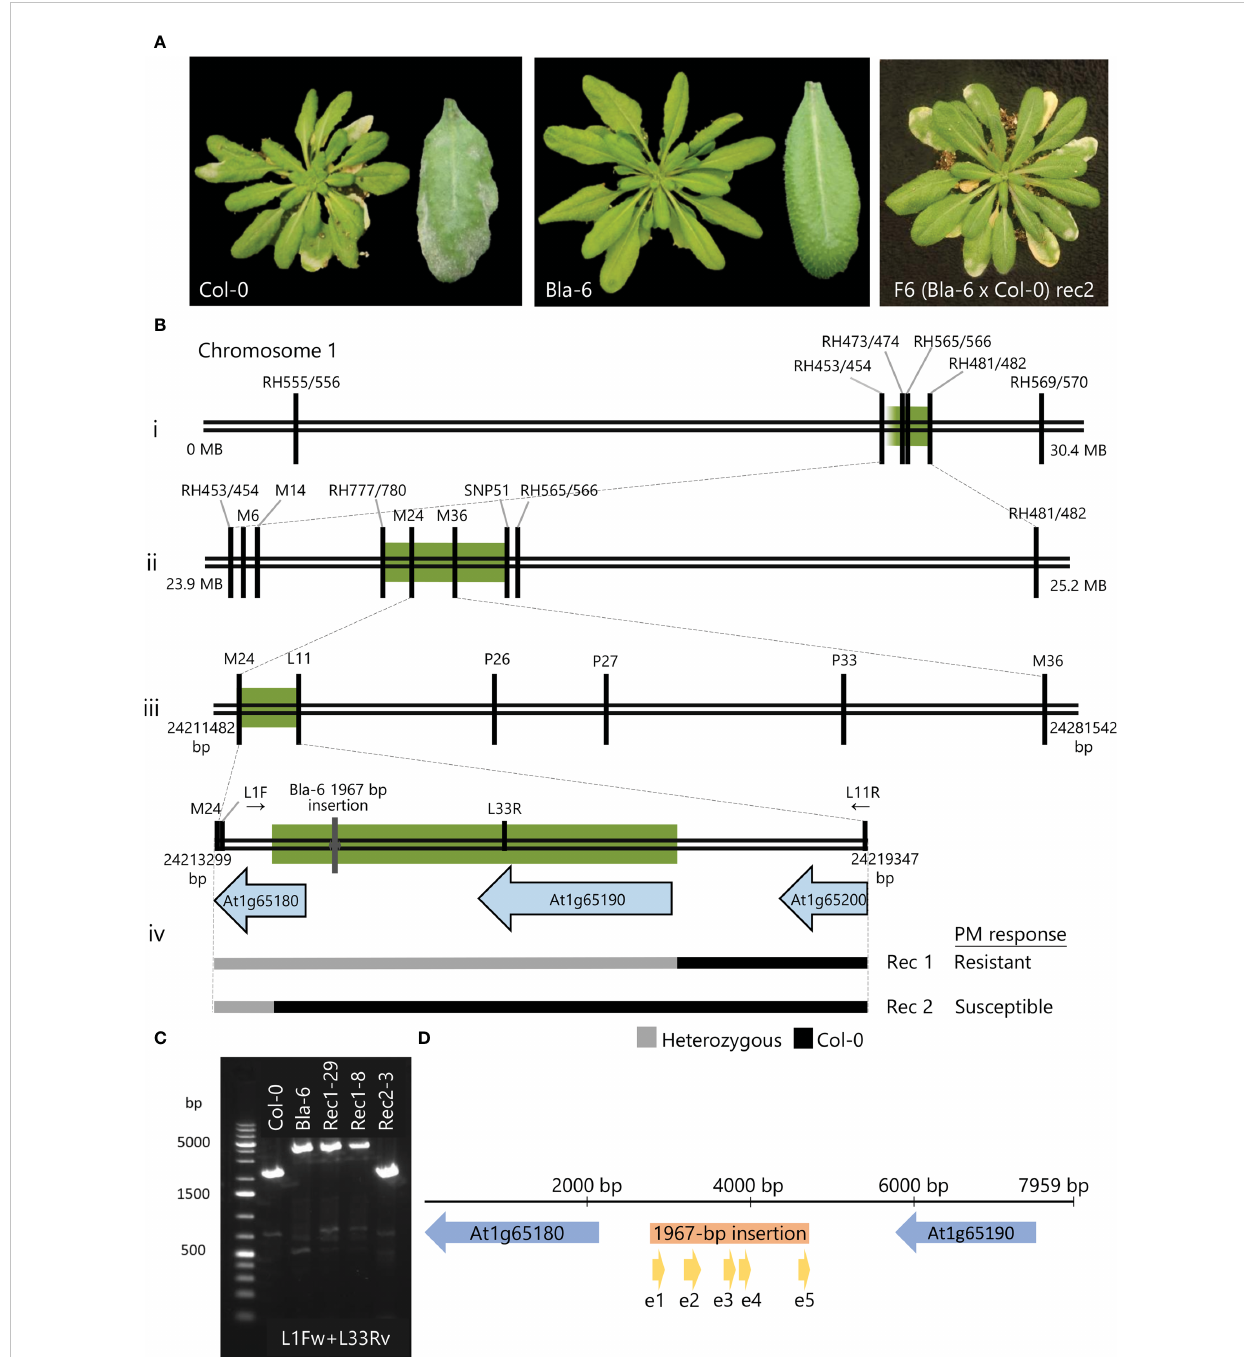
FIGURE 1 Fine-mapping of the resistance to Pseudoidium neolycopersici ( On ) in Arabidopsis accession Bla-6. (A) Disease response of Col-0 and Bla-6 to On at 12 days post-inoculation (12dpi): heavy sporulation over the infected leaves of susceptible accession Col-0 and lack of visible symptoms in accession Bla-6. On disease symptoms on F6 (Bla-6 x Col-0) progeny from susceptible recombinant Rec2. (B) Location of markers for fi ne-mapping of the resistance locus in chromosome 1: green bars indicate the candidate regions for each of the three recombinant screenings (i to iii) and PCR- based sequencing of F5 informative recombinants Rec1 and Rec2 with contrasting phenotypic response upon On inoculation (iv). (C) Agarose gel electrophoresis of the PCR product using L1F and L33R for wild-type Col-0 (2502-bp), Bla-6 (4469-bp) and F6 progeny of Rec1 (4469-bp) and Rec2 (2502-bp). (D) Assembled candidate region showing the candidate genes At1g65180 and At1g65190 (blue), and the 1967-bp insertion (orange) with its predicted exons